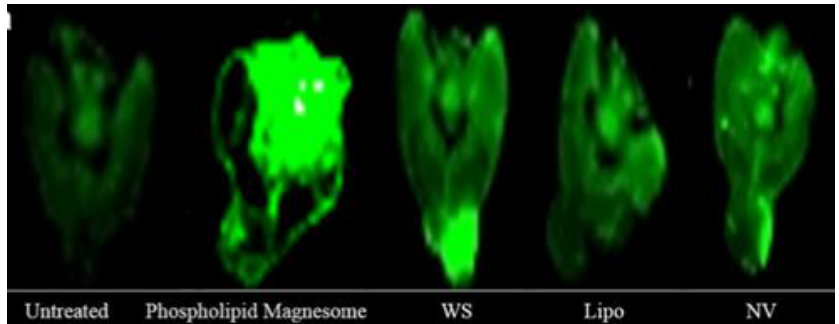
Figure 8. Delivery of epidermal growth factor (EGF) to the brain; near infrared imaging (NIR) image of brain of mice treated with 1 mg/kg EGF IRDye ® 800CW incorporated in phospholipid magnesome and in three control systems: water solution (WS), liposome (Lipo) and nonvesicular carrier (NV). Reproduced from Reference [152] with permission.